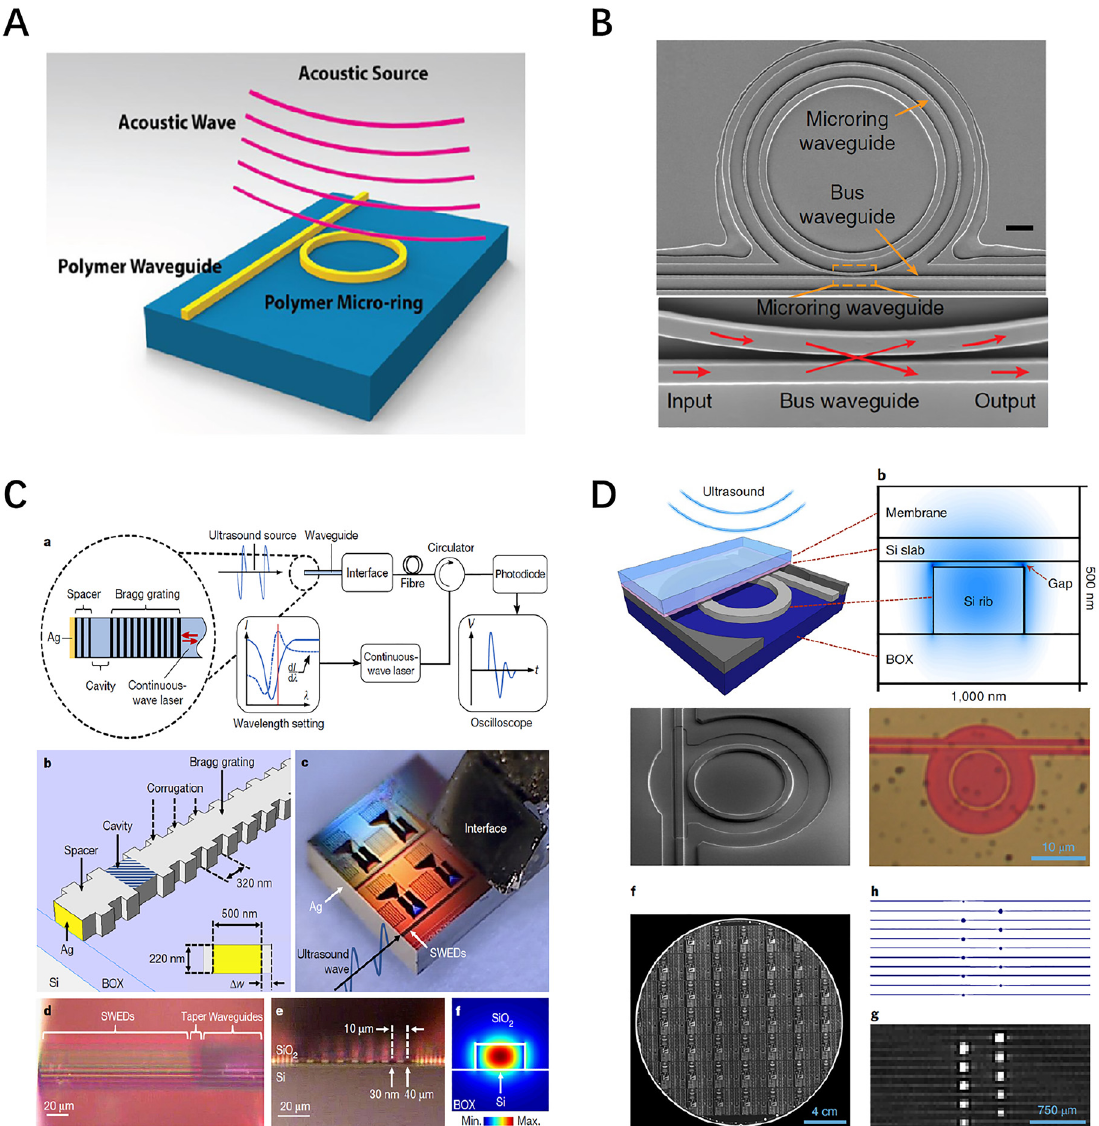
Figure 22: Photoacoustic sensing using integrated resonator systems: (A) polystyrene microring resonator [60]. (B) PDMS microring resonator [62]. (C) Silicon point-like silicon waveguide–etalon detector [64]. (D) Silicon microring resonator coupled with a membrane with a 15 nm air gap in between